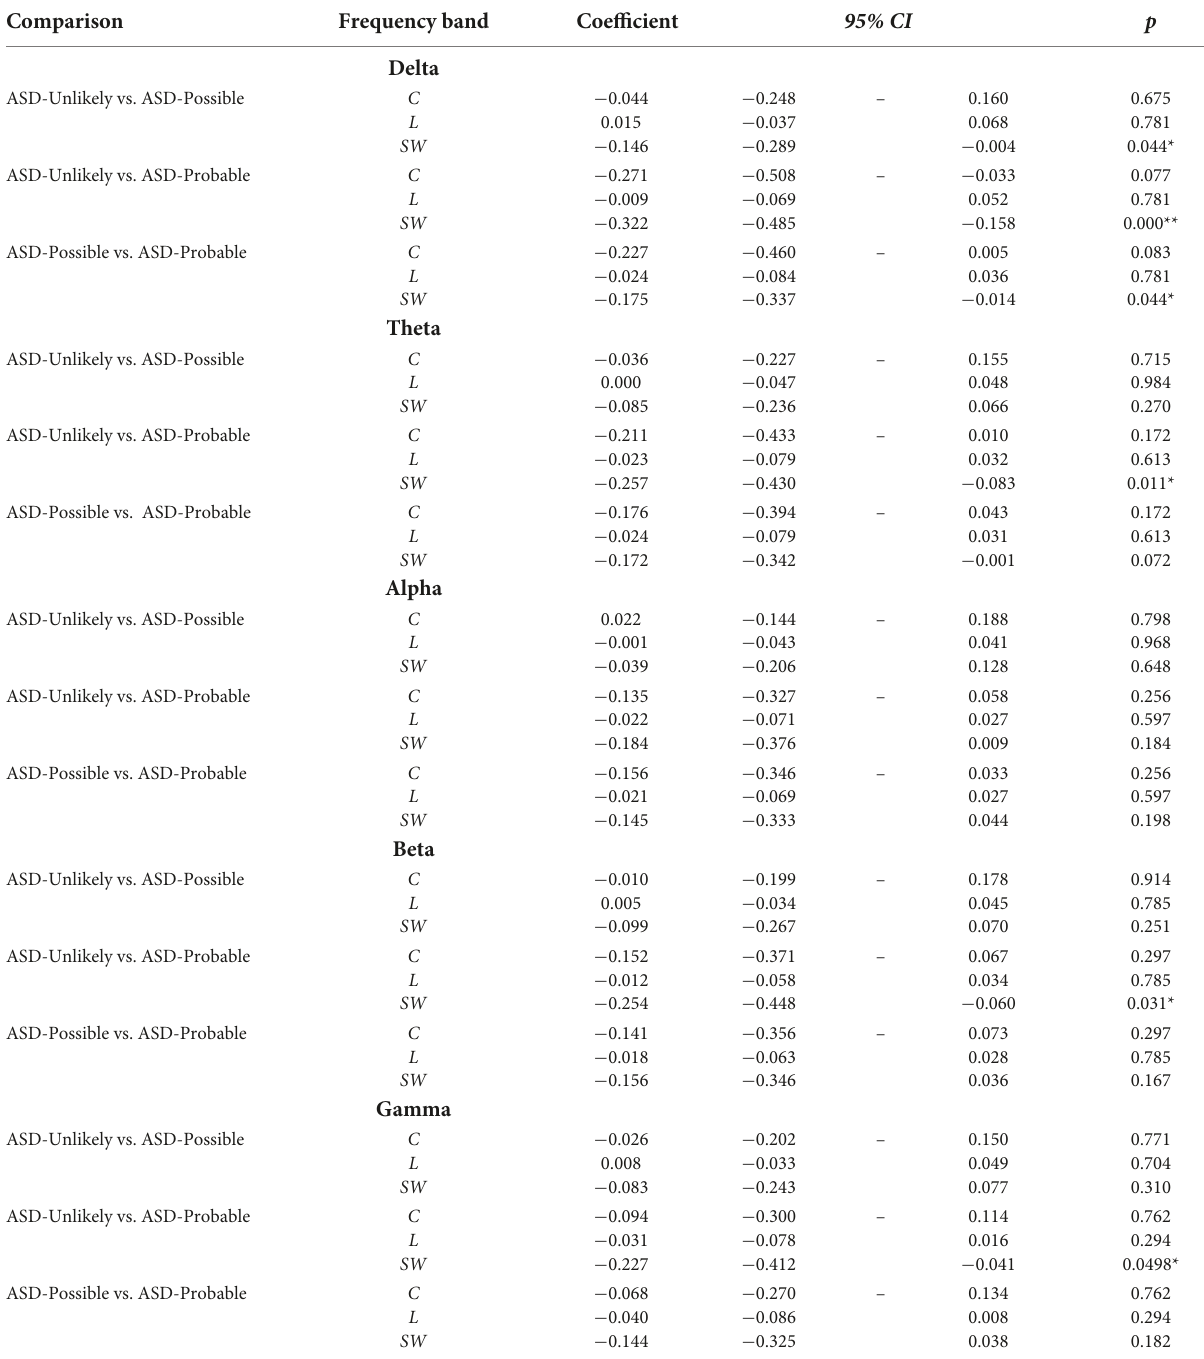
TABLE 3 Differences in graph